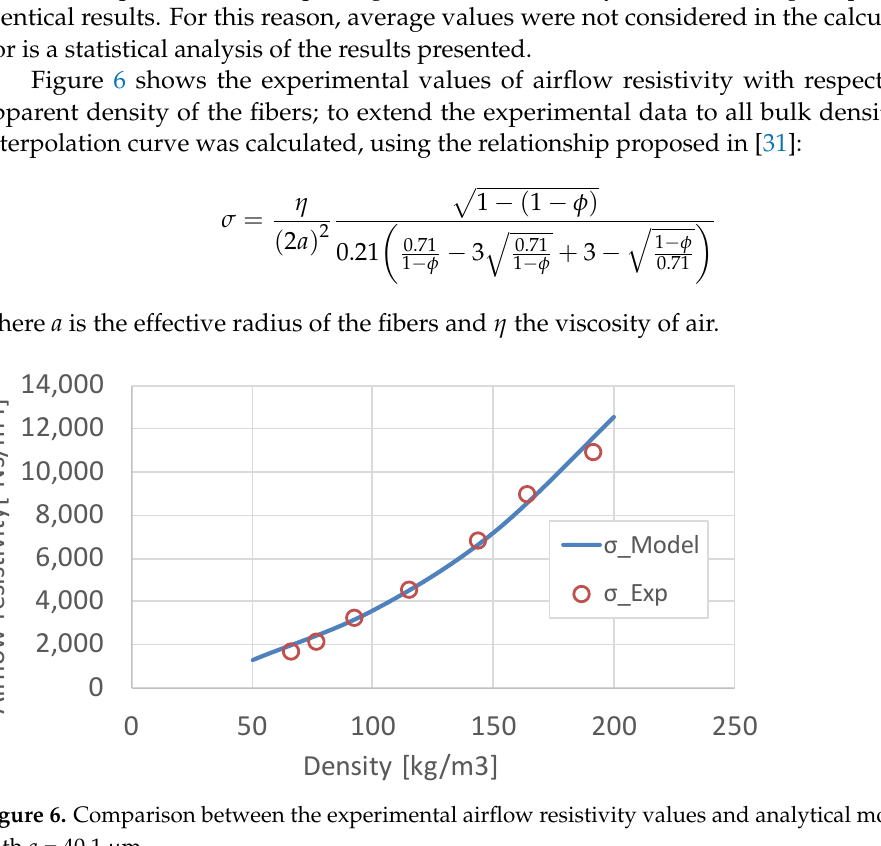
Figure 5. Porosity and tortuosity values as a function of the apparent density of the fibers, calculated with (9) and (11).